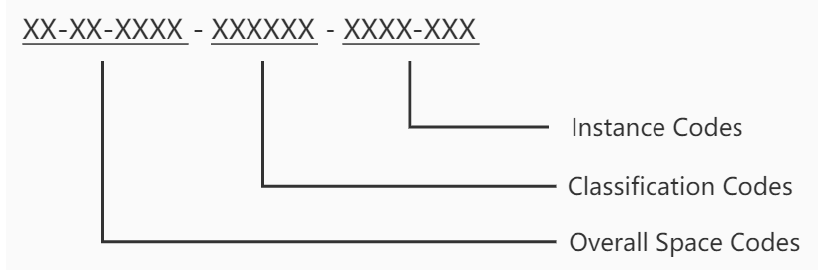
Figure 3. Interchange BIM components coding.